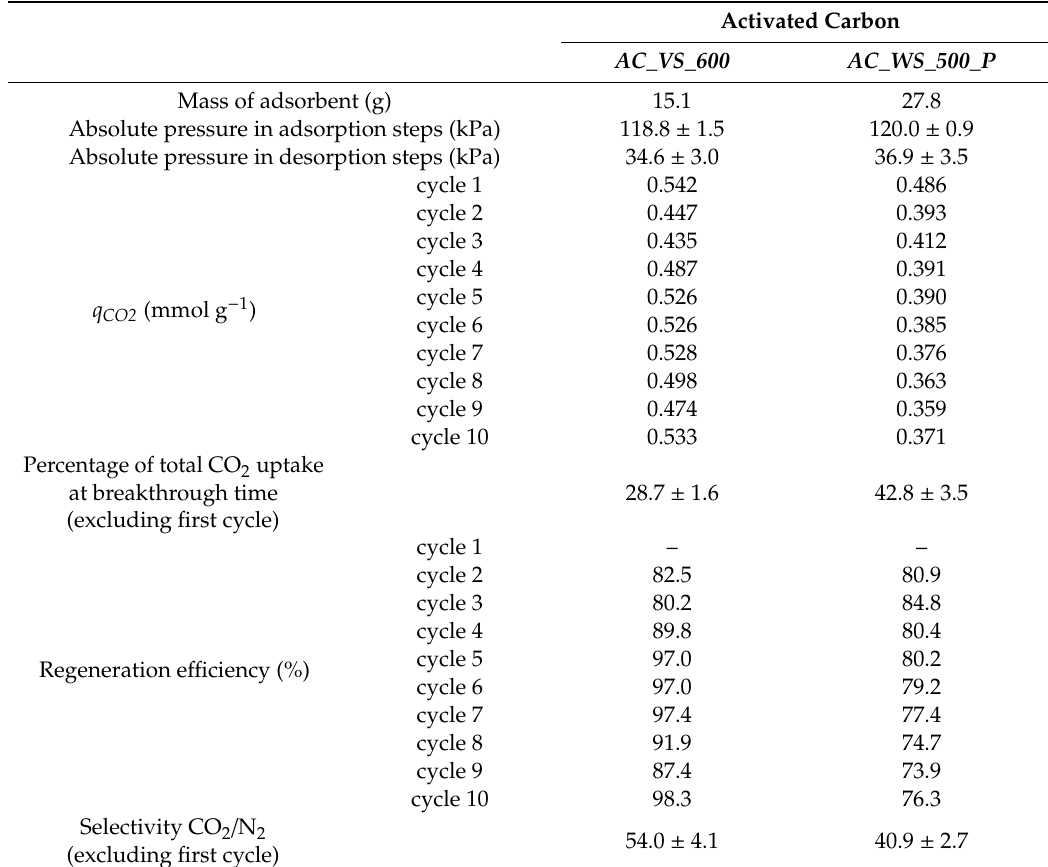
Table 7. Summary of results from the breakthrough experiments (humid conditions) conducted at 50 ◦